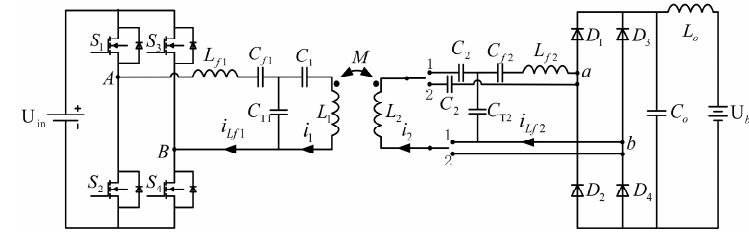
Figure 5. Bilateral L3C and L3C-C compensation network switching circuit.